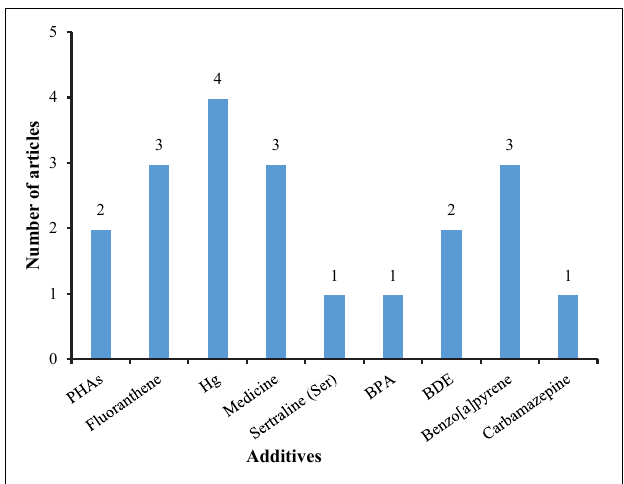
FIGURE 4 | The number of articles on the additives in mollusks exposed to microplastic.